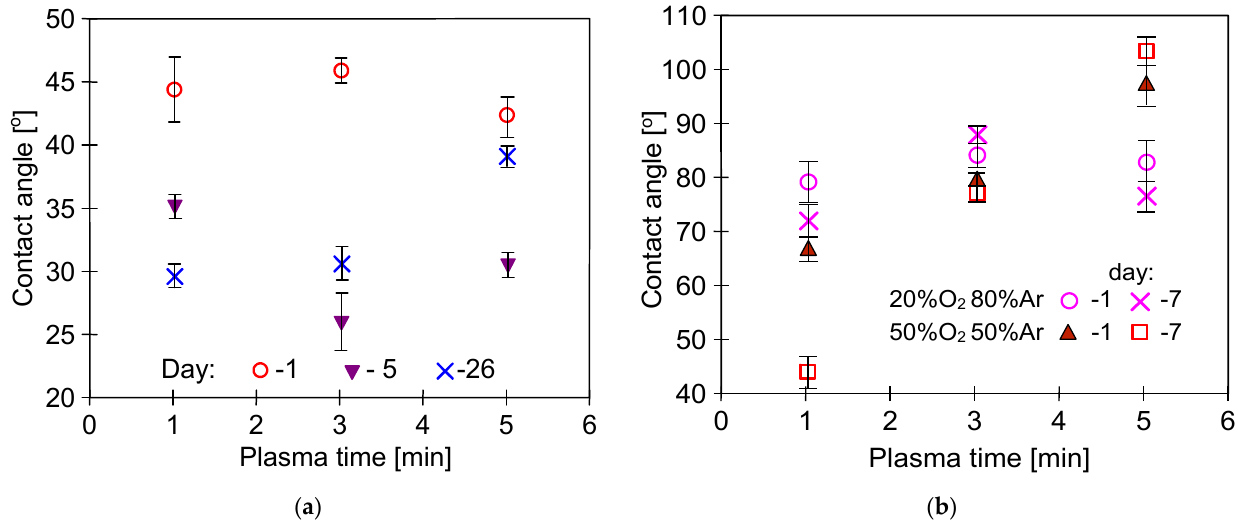
Figure 5. Durability of plasma effects: ( a ) plasma: pure Ar (1–26 days); ( b ) plasma: Ar–oxygen mixture (1–7 days). Plasma power 200 W and flow rate: 90 mL/min.